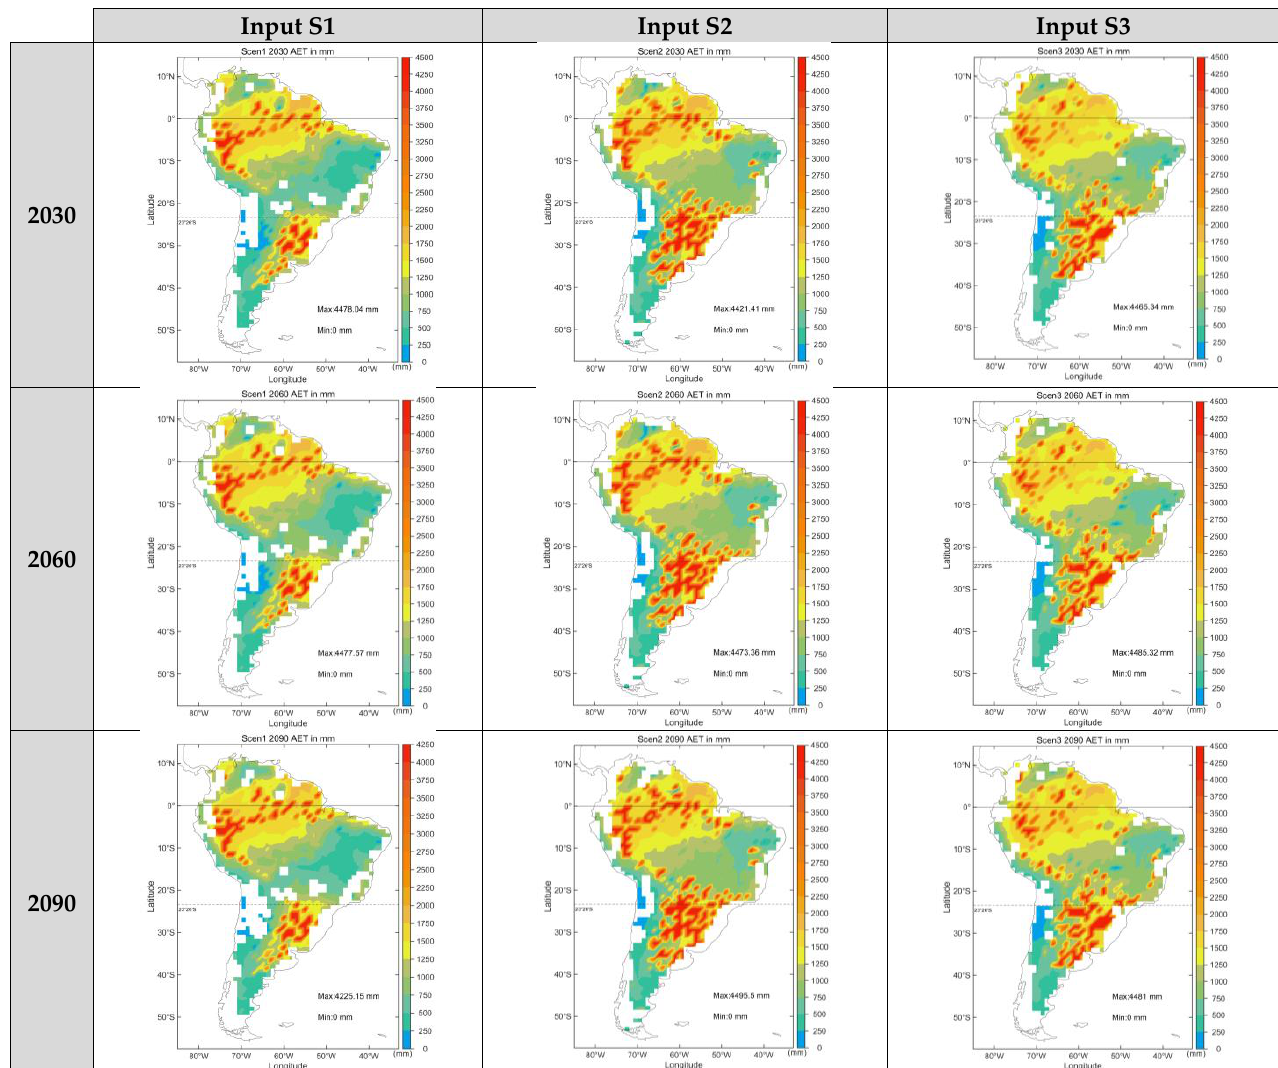
Figure 10. The joint optimal prediction of two models under different input